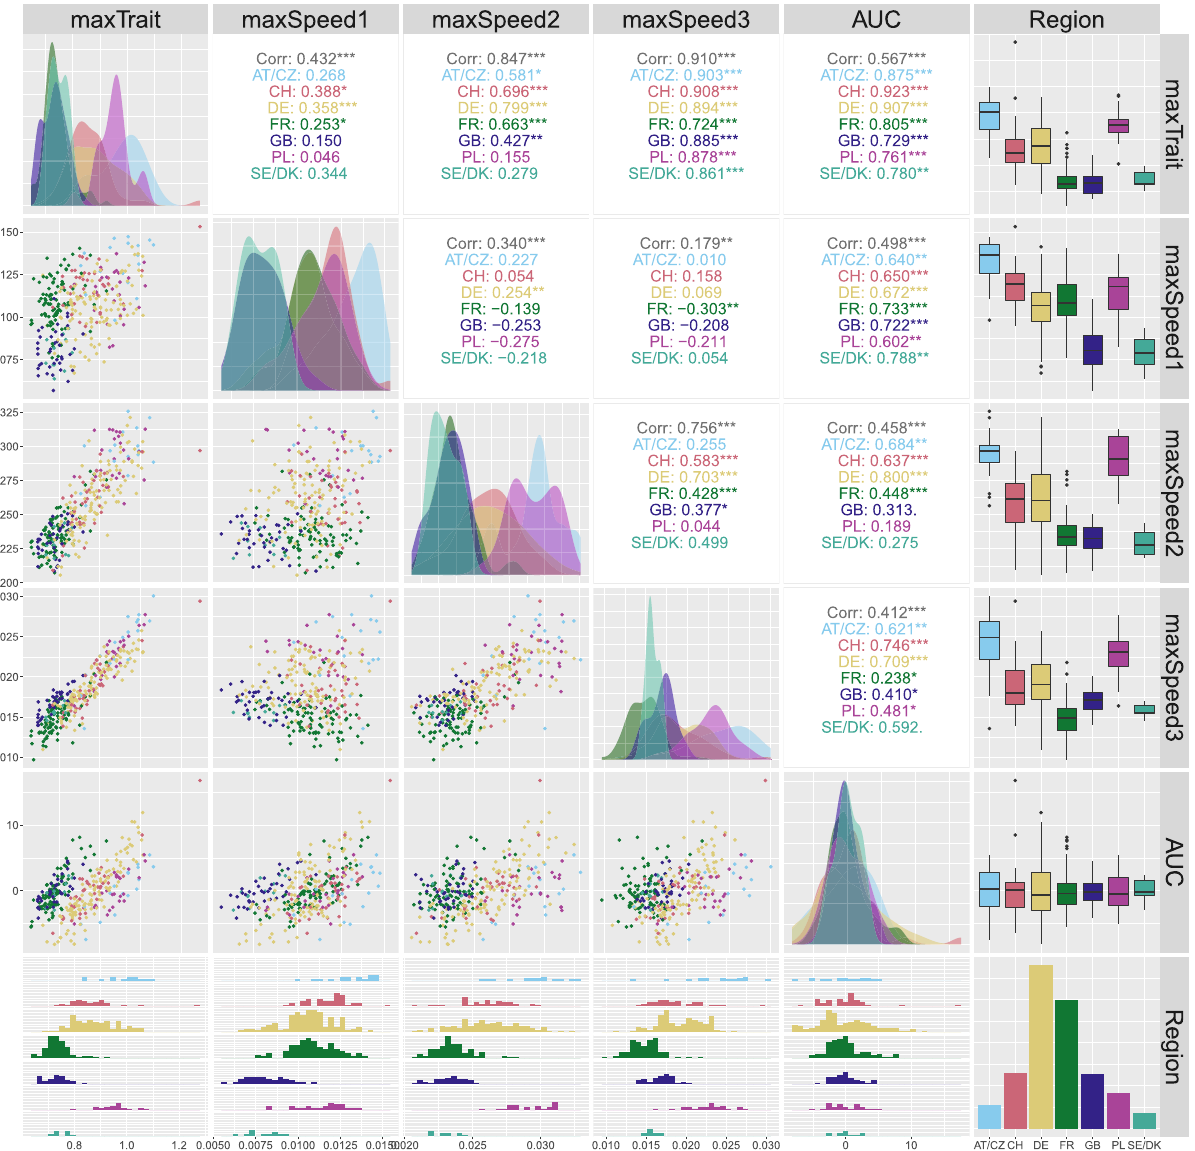
Figure 8. Scatterplots matrix with the extracted attributes at the genotype level for the ETH field phenotyping platform. The lower off diagonal depicts bivariate scatterplots, the diagonal shows the conditional densities of each attribute per region, the upper off diagonal indicates the bivariate Pearson correlation (marginal and by region; “***” p-value < 0.001, “**” p-value < 0.01, “*” p-value < 0.05, “.” p-value < 0.10 and “” otherwise), the last column displays the boxplots of each attribute per region, the last row depicts the conditional histograms of each attribute per region, and the bottom right barplot shows the number of genotypes per region. AT/CZ: Austria/ Czechia; CH: Switzerland; DE: Germany; FR: France; GB: Great Britain; PL: Poland; SE/DK: